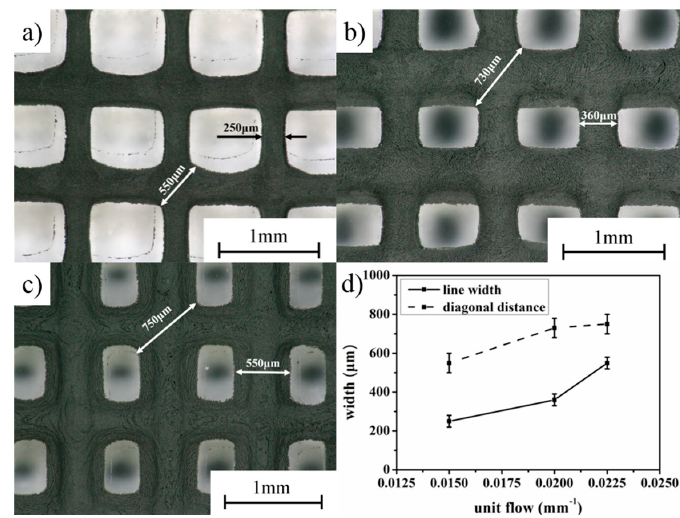
Figure 5. Comparison on the printing accuracy of LTDW printed grid patterns using different parameters: ( a ) v j = 0.003 mm/s, v xy = 2 mm/s, h s = 0.1 mm; ( b ) v j = 0.006 mm/s, v xy = 2 mm/s, h s = 0.15 mm; ( c ) v j = 0.009 mm/s, v xy = 4 mm/s, h s = 0.1 mm; ( d ) variation of line width and diagonal distance with unit flow equivalent number.